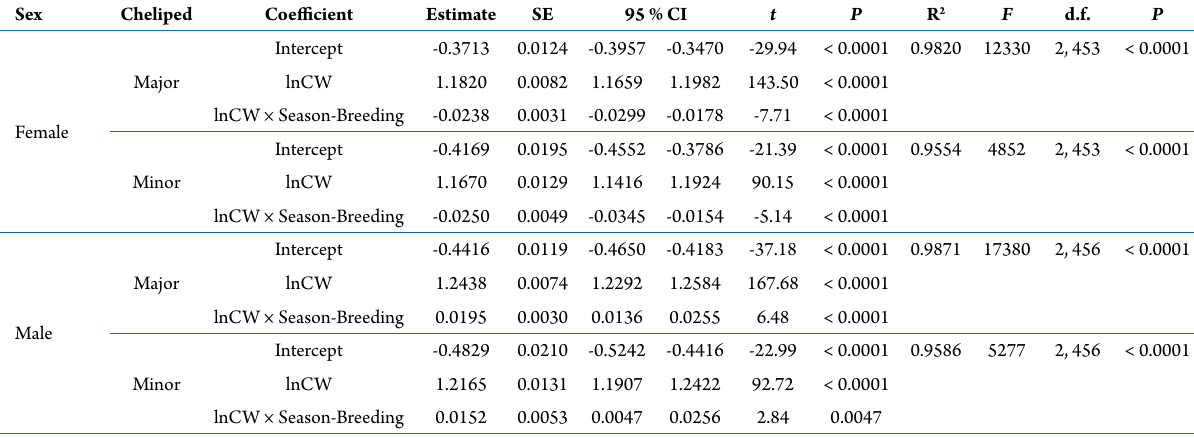
Table A4. Coefficient estimates with standard errors (SE) and their 95 % confidence intervals (CI) for the explanatory variables of log-transformed allometric growth equation models to evaluate the intrasexual chela size dimorphisms of major or minor chelipeds between the breeding (May to September) and non-breeding seasons (October to April) of the porcellanid crab Petrolisthes japonicus . The linear equation model was as follows: lnChS = ln a + b lnCW + c lnCW × Season, where ChS is the chela size (geometric mean of the propodus length and width), CW is the carapace width, and Season is the breeding season or non-breeding season. The coefficient estimate for each explanatory variable, including the Season, was the output for the breeding season, representing changes in the response variable relative to the baseline category (non-breeding season). The statistical significance of the coefficient estimates and each model was evaluated with t -tests and F -tests, respectively.